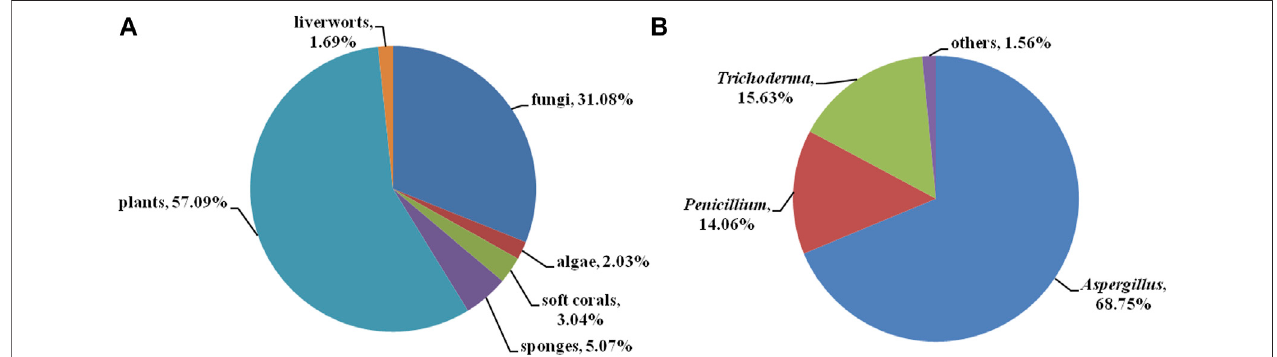
FIGURE 8 | (A) Source categories of the described bisabolanes; (B) Categories of the marine fungi-derived bisabolanes.